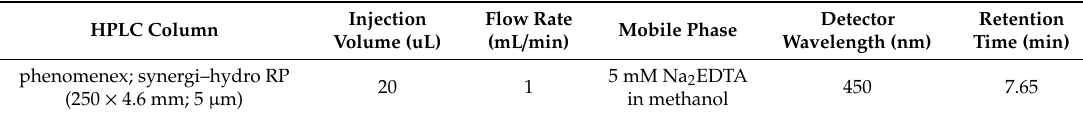
Table 8. HPLC parameters for AmB